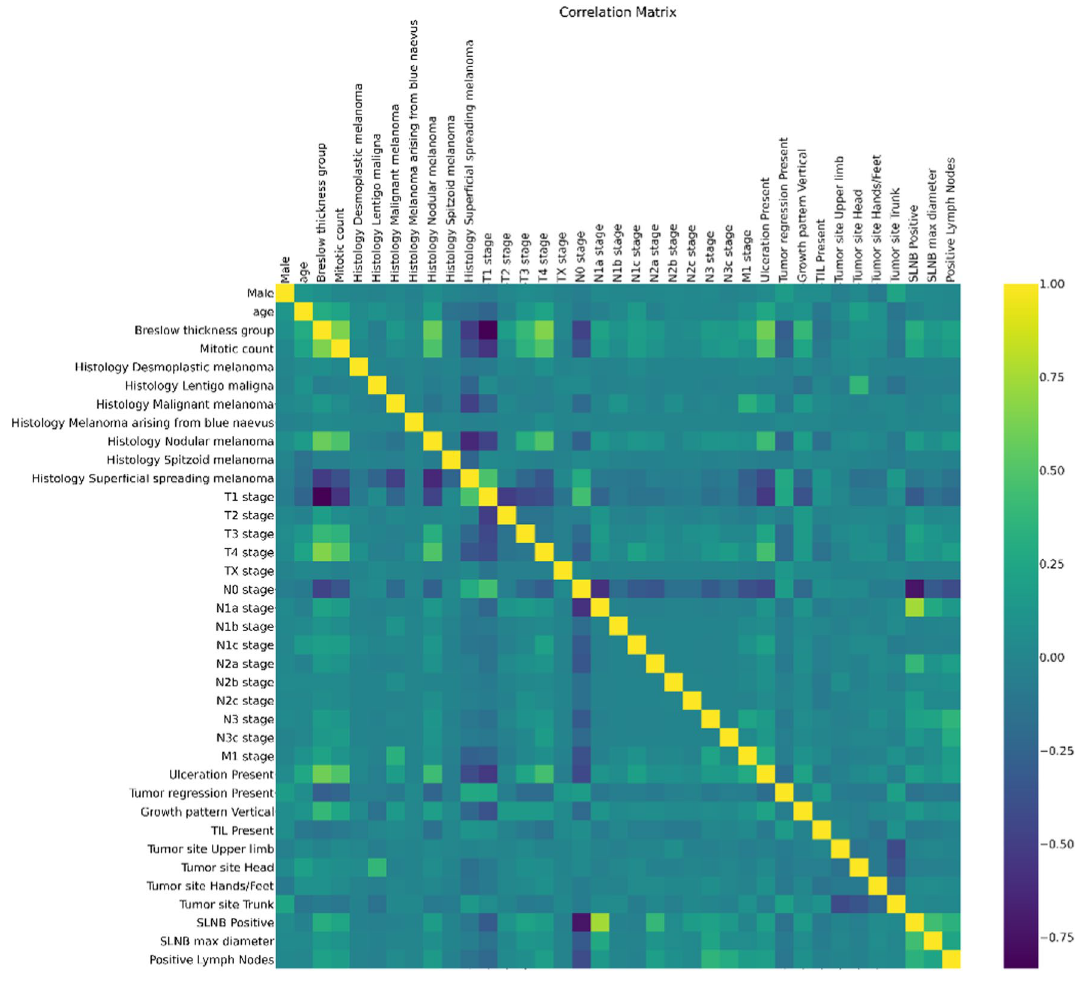
Fig. 3 Features correlation